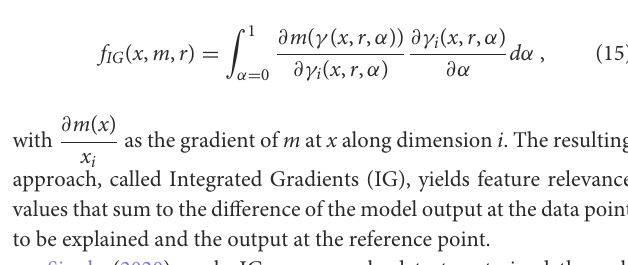
the straight-line path between x and r as γ ( x , r , α ) : R d , R d , [0, 1]